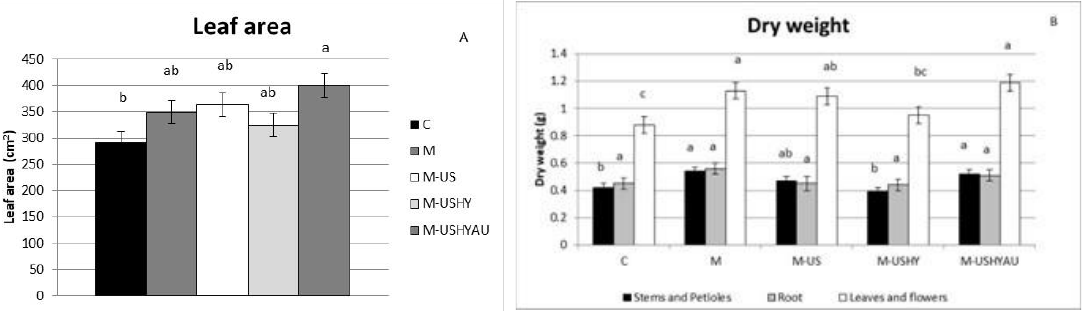
Figure 4. Leaf area (cm 2 ) ( A ) and dry weight ( B ). Data are means ± standard error. Values followed by different letters are significantly different ( p ˂ 0.05). The values are the means of data from 12 plants for each replicate.